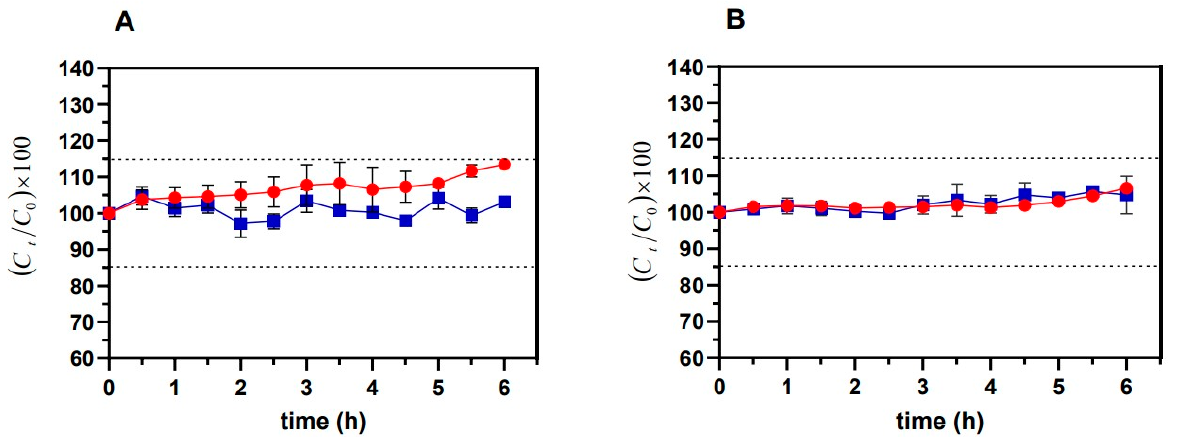
Figure 1. Percentage variation of the starting CYT concentration (100%) over time in ( A ) simulated salivary fluid (pH 6.8) and ( B ) PBS (pH 7.4). The measurements were carried out by UV-Vis (red) and HPLC-DAD (blue) methods. Results are presented as means ± SE (n = 3).